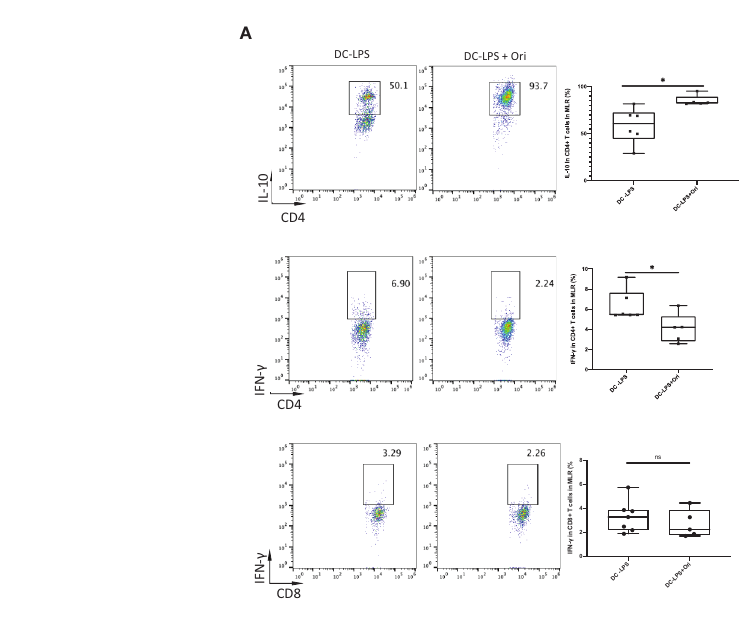
FIGURE 7 | Ori-treated BMDCs could decrease the production of IFN- g , increased the IL-10, and expanded Tregs in vitro . Coculture the two types of B6-derived DCs (DC-LPS and DC-LPS + Ori) (stimulator) with C3H-derived T cells (responder) in the ratio of 1:10 for 5 days in vitro for one-way MLR. Then, cells were collected and stained with multiple Abs including the intracellular ones. (A) The frequencies of CD4 + IL-10 + , CD4 + IFN- g + T cells and CD8 + IFN- g + T cells. (B) Tregs (CD25 + FoxP3 + gated from CD4 + T cells) were analyzed by FCM. Representative graphs are given for each group. Values are shown as the mean ± SD; * p < 0.05, ** p <